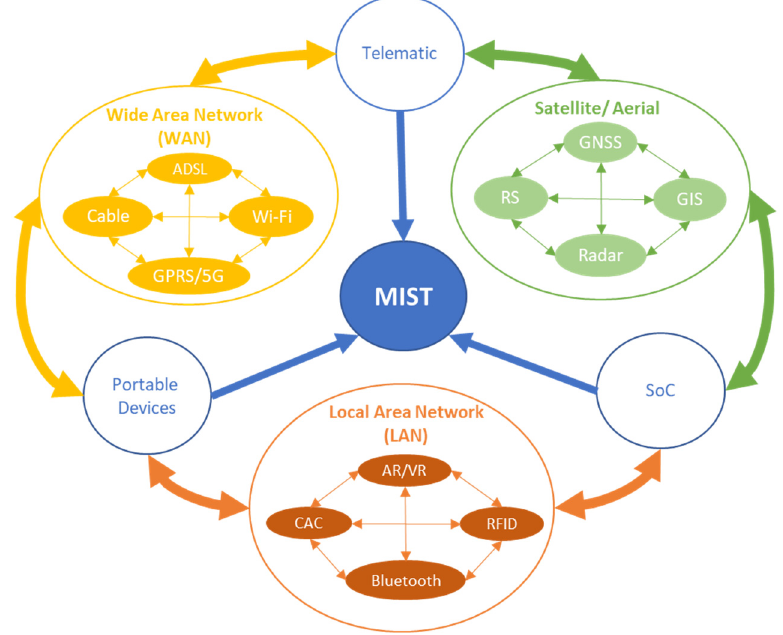
Figure 3. Internet of Things (IoT) covering the information and communication technologies (ICTs).